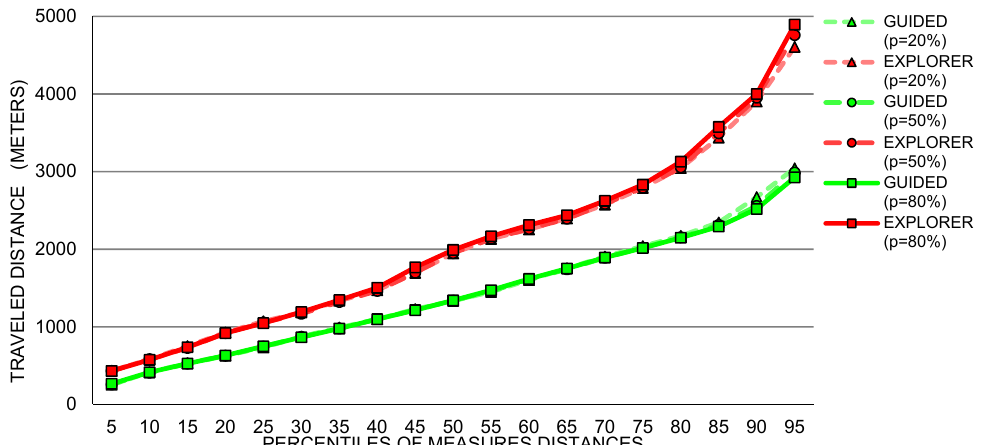
Figure 6. Difference in traveled distance between ‘Explorer’ and ‘Guided’ agents, as seen using percentiles and considering p = 20%, p = 50%, and p =